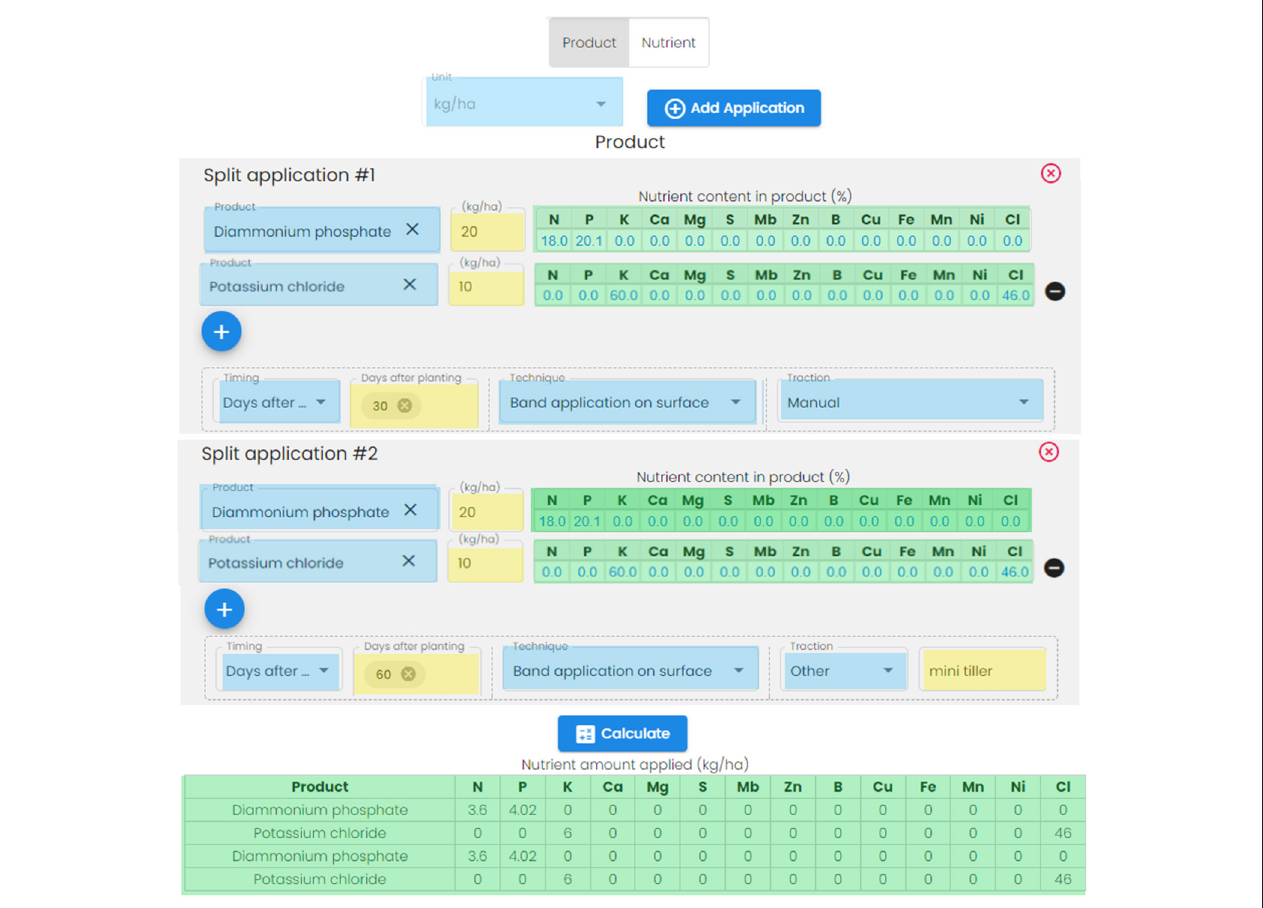
FIGURE 7 | Fertilizer pop-up window, showing system-generated information (light green); standardized choices (light blue); and user-entered text (pale yellow).